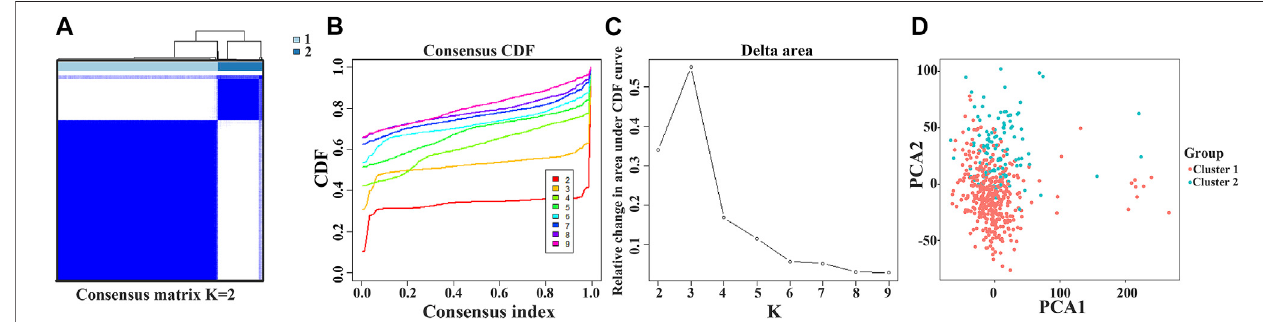
FIGURE 8 | Consensus clustering of model factors in LUAD. Note: LUAD, lung adenocarcinoma.